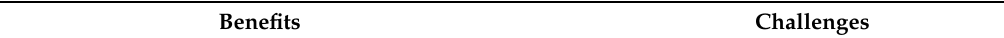
Table 3. Challenges and benefits of a university–child welfare sector partnership in Ontario. Benefits Challenges Resources for sustainability of